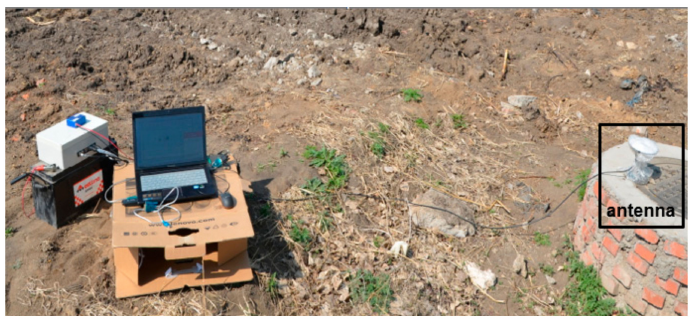
Figure 11. Base station of the BDS.